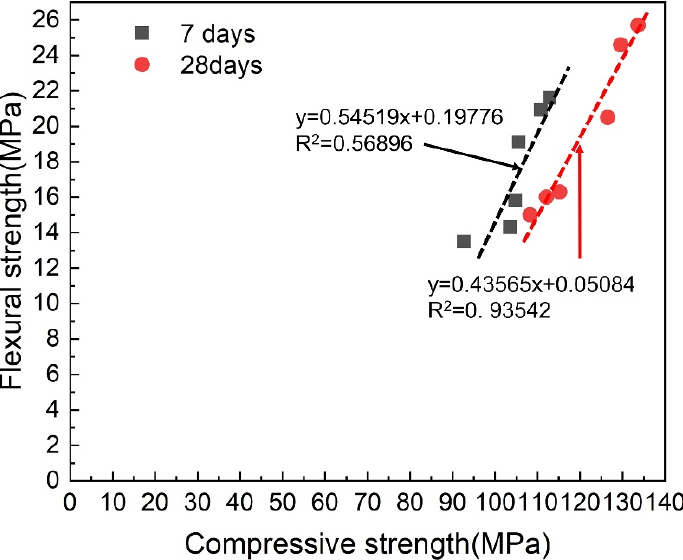
Figure 9. Correlation of compressive strength and flexural strength of the 6wt.% straight BCSF-re- inforced UHPC cured at 7 days and 28 days.